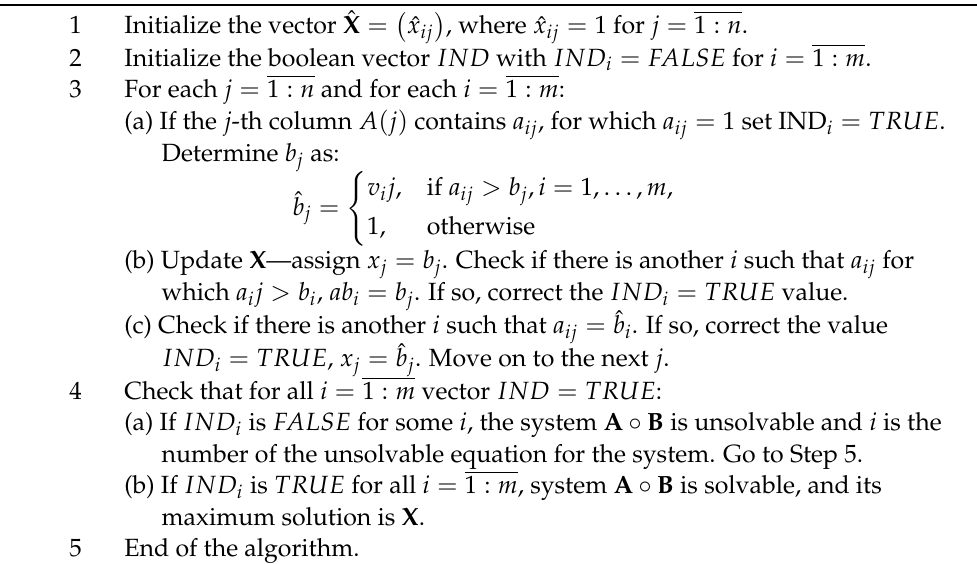
Algorithm 1: Determination of the maximum solution and solvability.